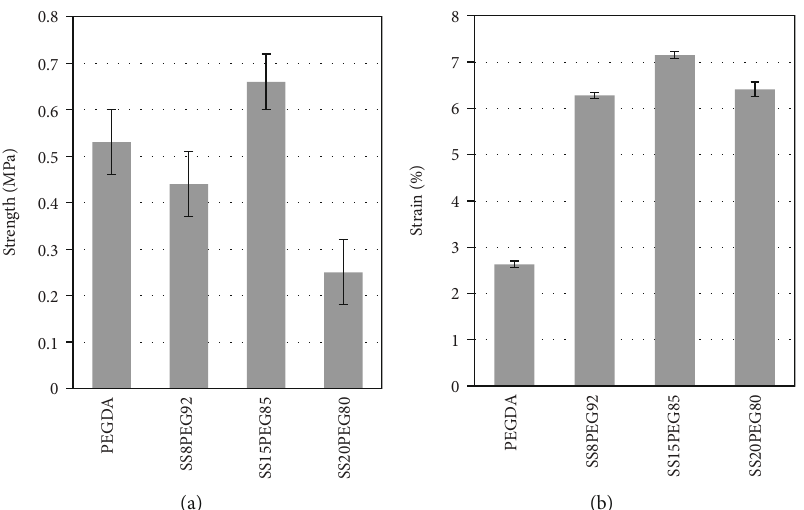
Figure 5: The compressive strength (a) and strain (b) of di ff erent hydrogel samples ( n = 3 ).